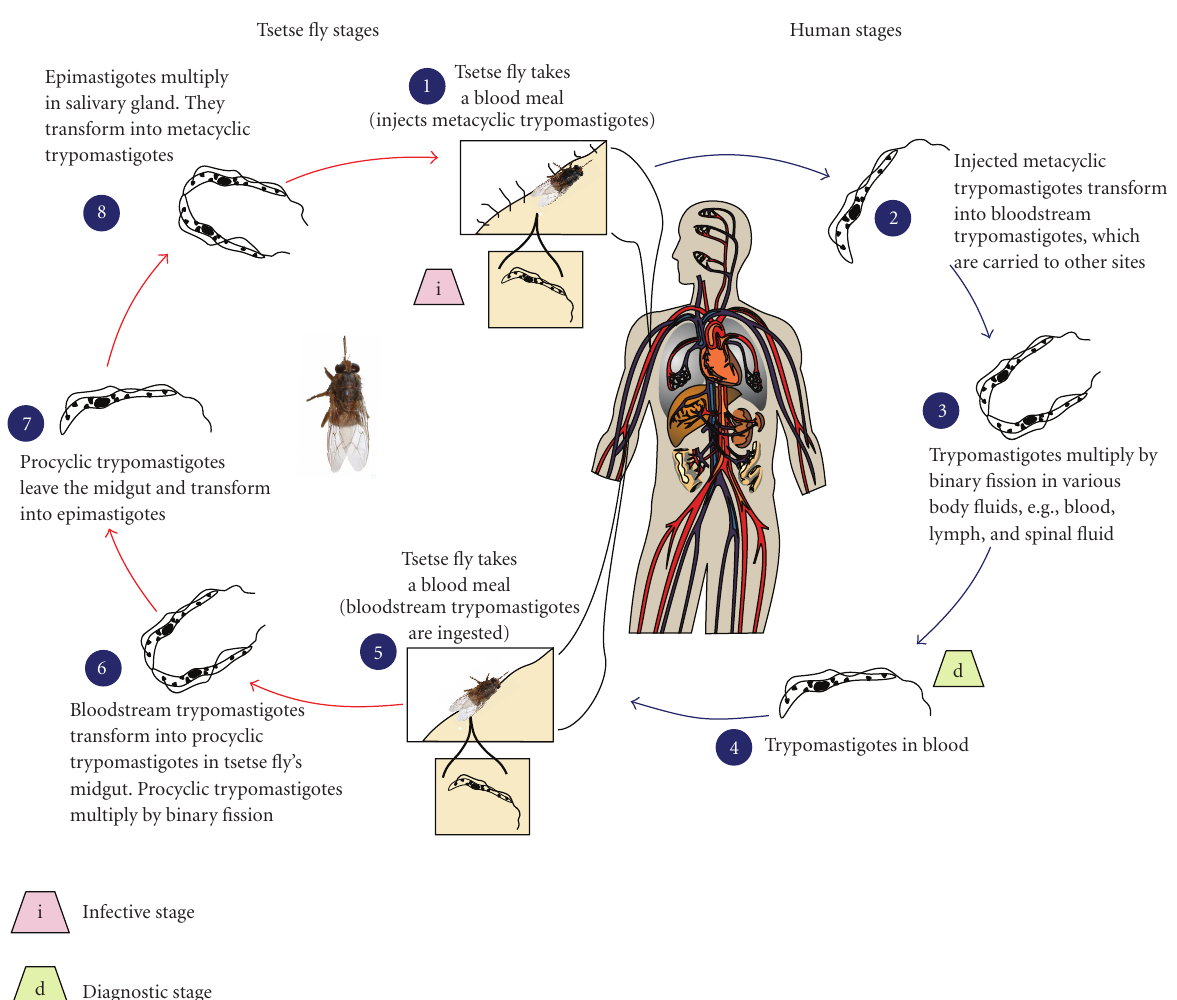
full-length pseudogenes (with frame shifts and/or